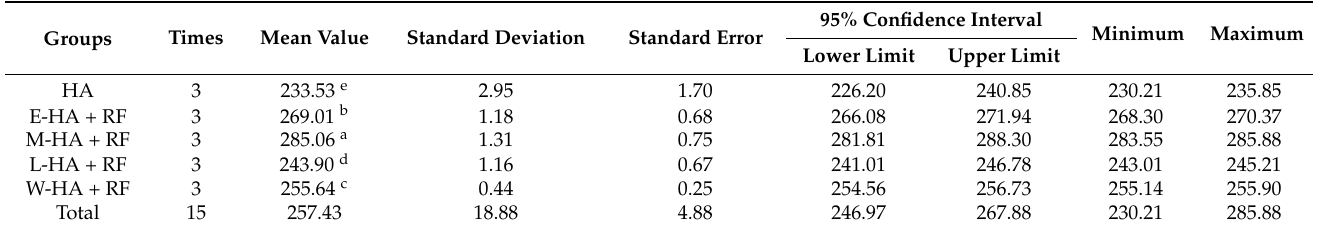
Table 1. Effect of RF heat treatment on AAC of hot air-dried jujube slices.